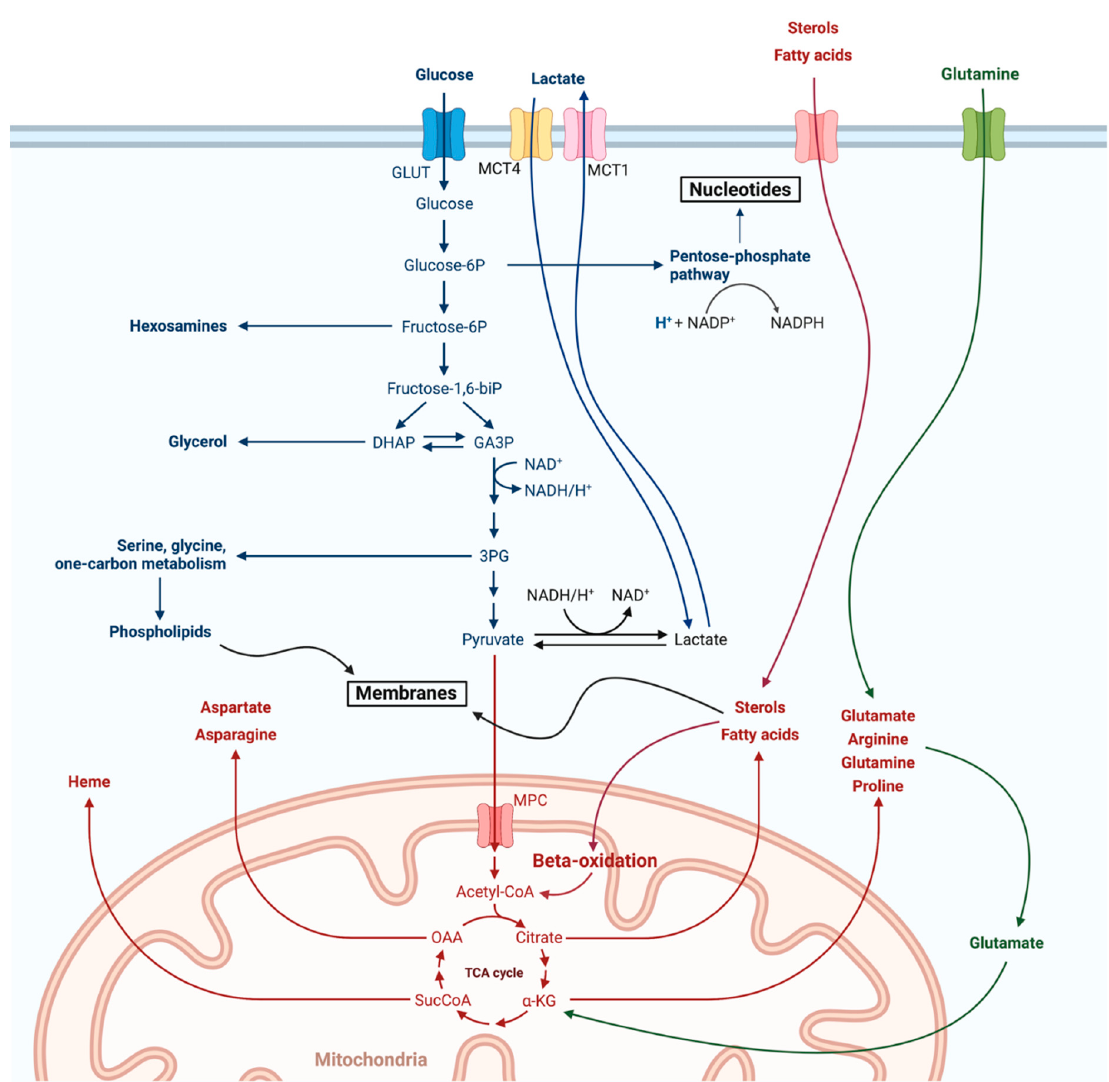
Figure 2. Overview of cellular metabolism. Both the Warburg glycolysis (blue) as well as mitochondrial OxPhos (red) are shown here along with their major branching and/or feeding pathways. Anaplerosis of the TCA through glutaminolysis is of special interest as it will be discussed further in the article and is depicted in green. Adapted from “Warburg Effect”, by BioRender.com (2020). Retrieved from https://app.biorender.com/biorender-templates (accessed on 6 July